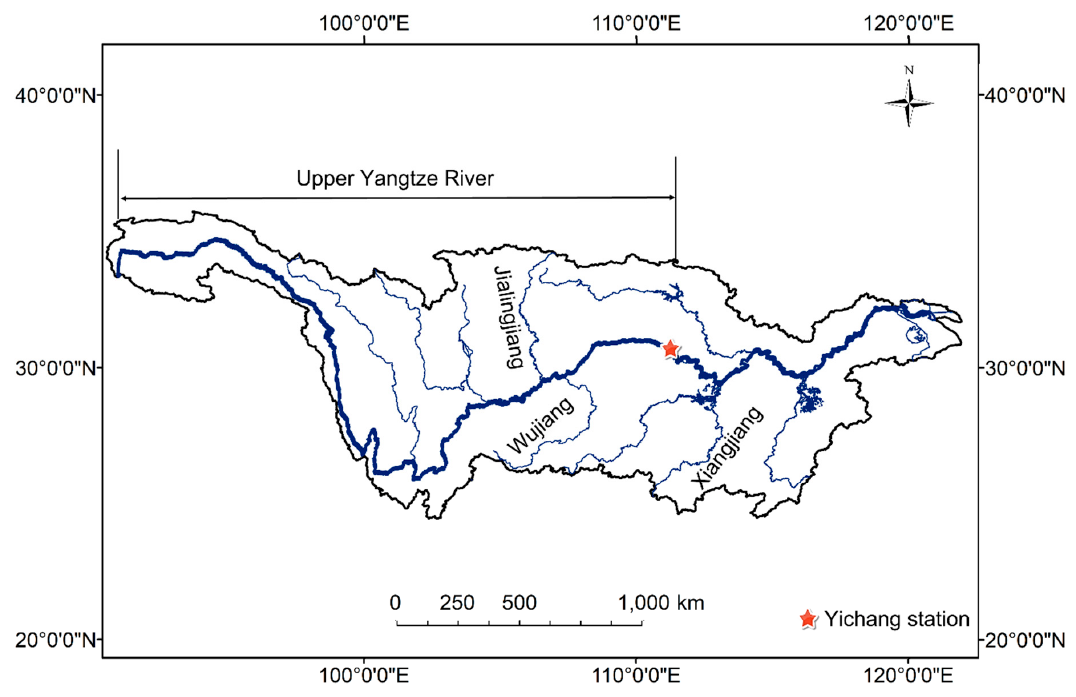
Figure 1. A map of the Yangtze River basin.